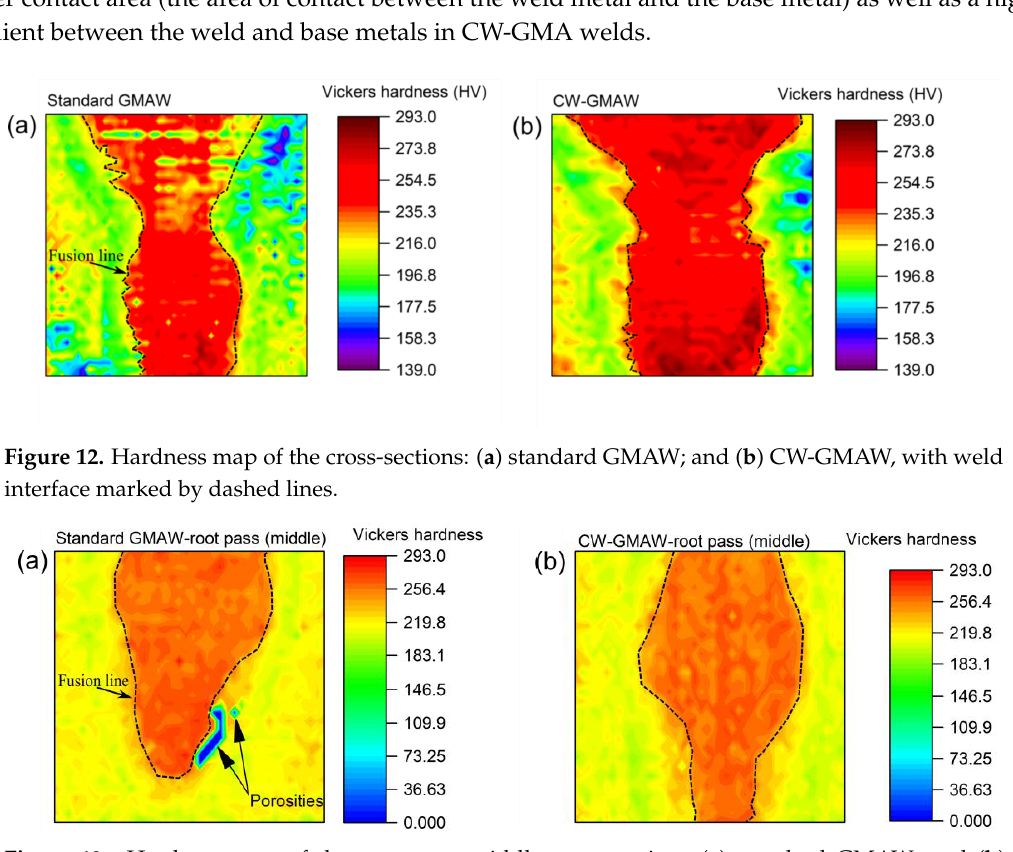
Figure 13. Hardness map of the root pass, middle cross-section: ( a ) standard GMAW; and ( b ) CW-GMAW, with weld interface marked by dashed